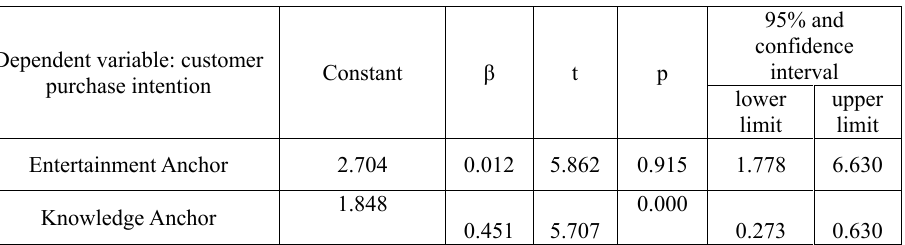
Table 2. Main effect model